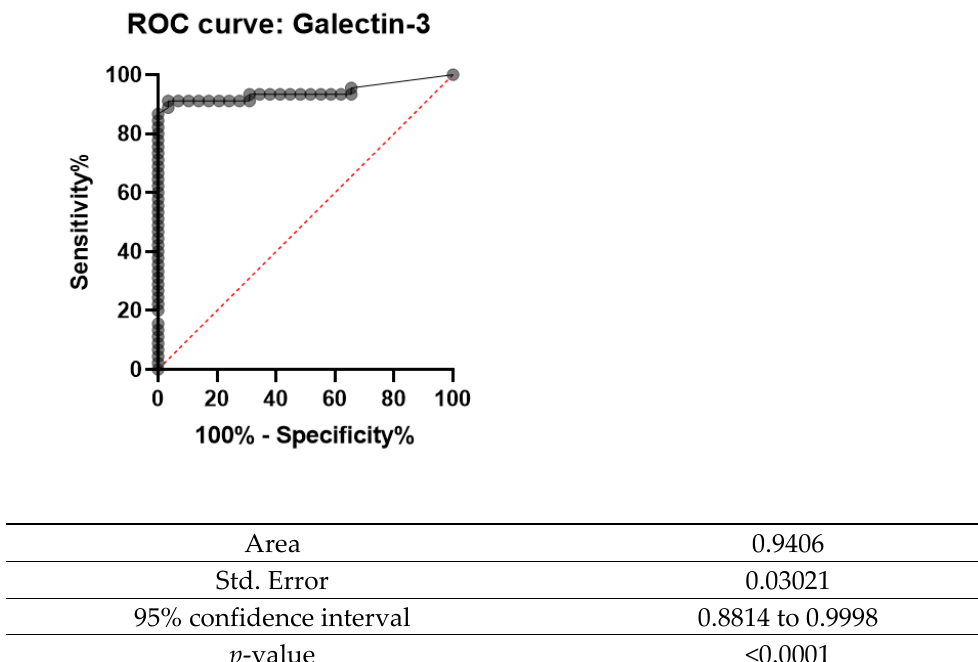
Area under curve 0.9542 Std. error 0.02095 95% confidence interval 0.9132 to 0.9953 p -value <0.0001 Figure7. ROC curve for HBME-1 (2008 and 2013).